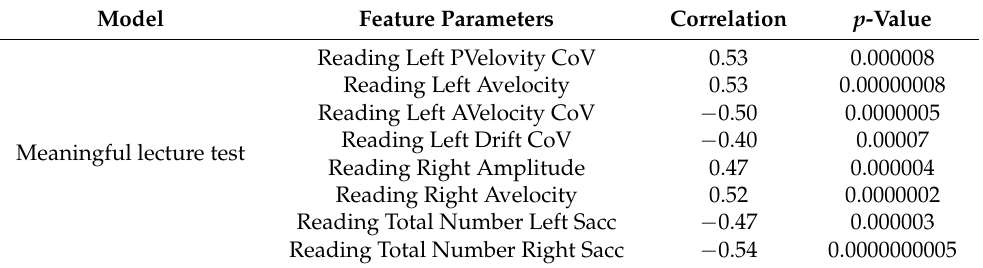
Table 7. The eye movement parameters selected for the Alouette and meaningful lecture data sets.